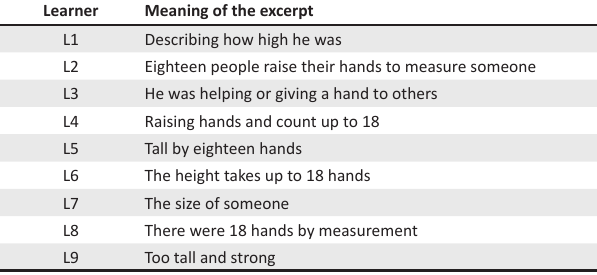
TABLE 3: Learners’ responses to ‘Boxer was eighteen hands high and strong’. Learner Meaning of the